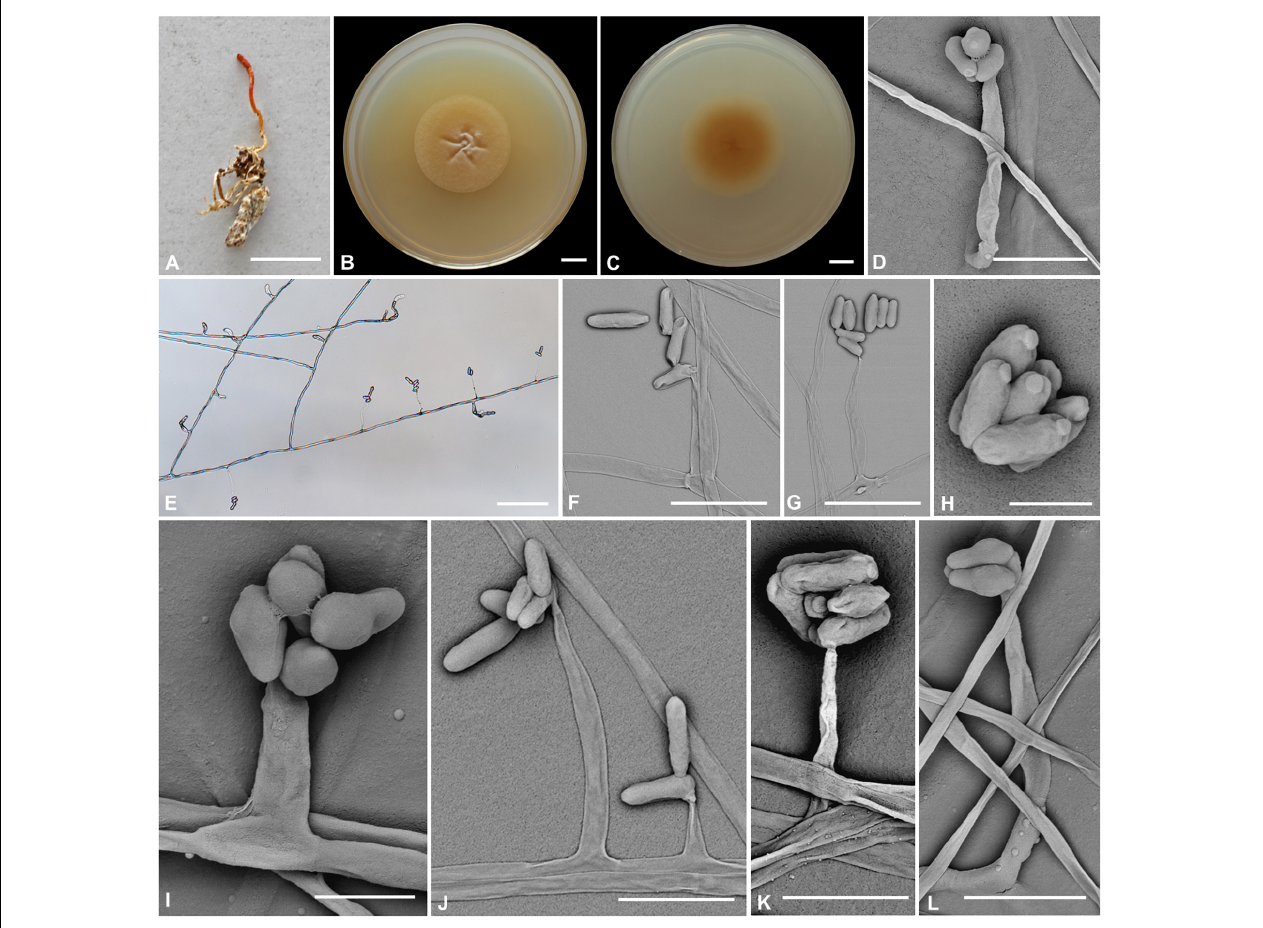
FIGURE 2 | Cordyceps bullispora . (A) Fungus on the pupa of Lepidoptera. (B,C) Colony obverse (B) and reverse (C) on PDA at 21 days. (D–G,I–L) Phialides. (H) Conidia. Scale bars: (A) = 10 mm; (B,C) = 10 mm; (D) = 25 µ m; (E) = 50 µ m; (F,G) = 15 µ m; (H) = 3 µ m; (I) = 5 µ m; (J) = 15 µ m; (K,L) = 10 µ m.